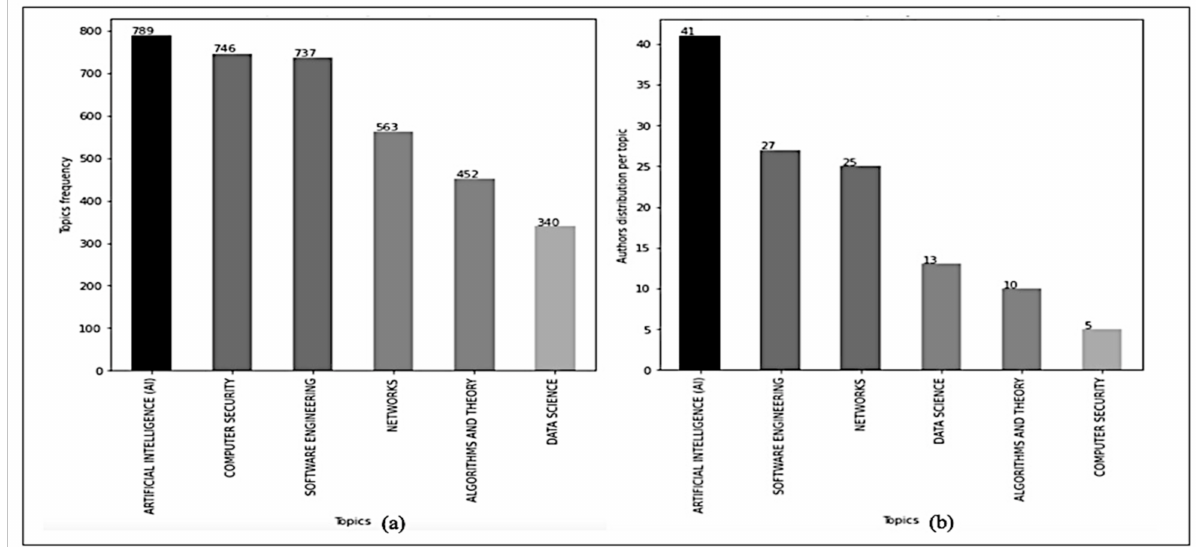
Figure 16. Topics’ distribution. ( a ) The total number of publications on each topic; ( b ) The total number of authors in each